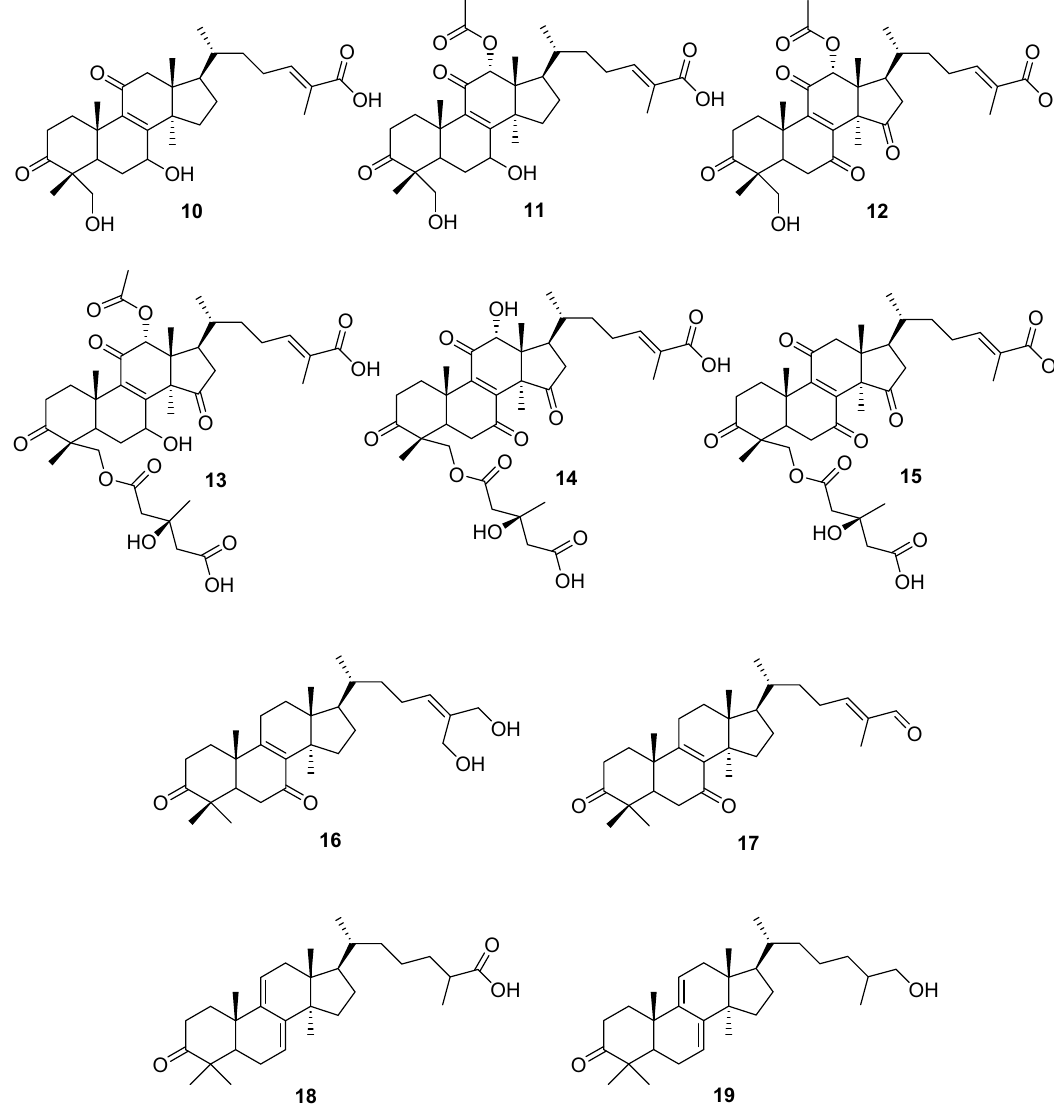
Figure 4. The triterpenoids isolated from G. leucocontextum and G. lucidum showed strong inhibitory activity against HMG-CoA reductase.